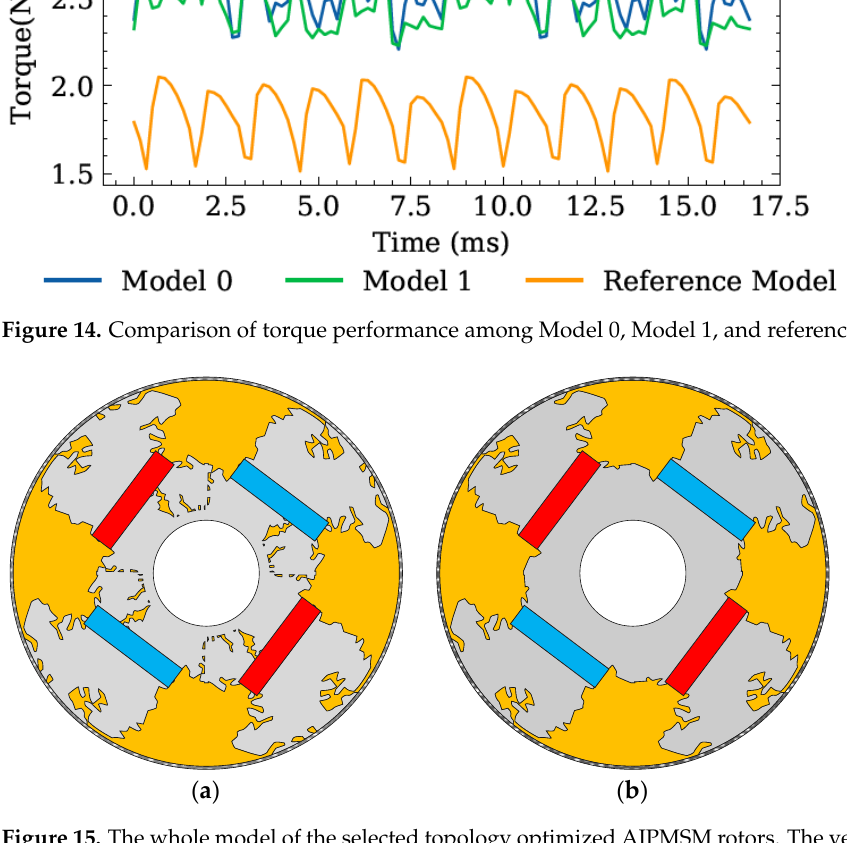
Figure 14. Comparison of torque performance among Model 0, Model 1, and reference model.